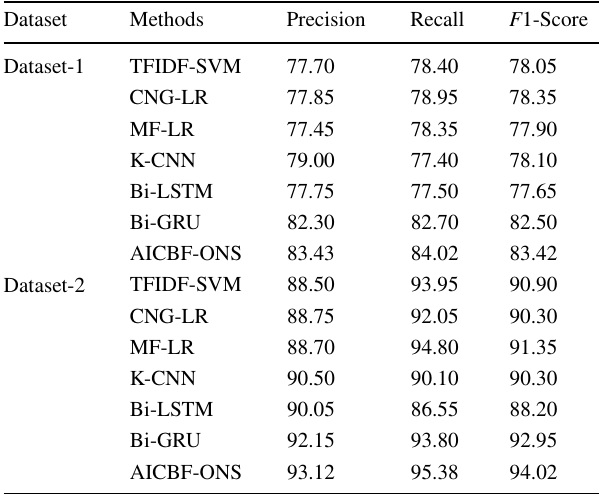
Table 3 Results analysis of existing with proposed method in terms of different measures